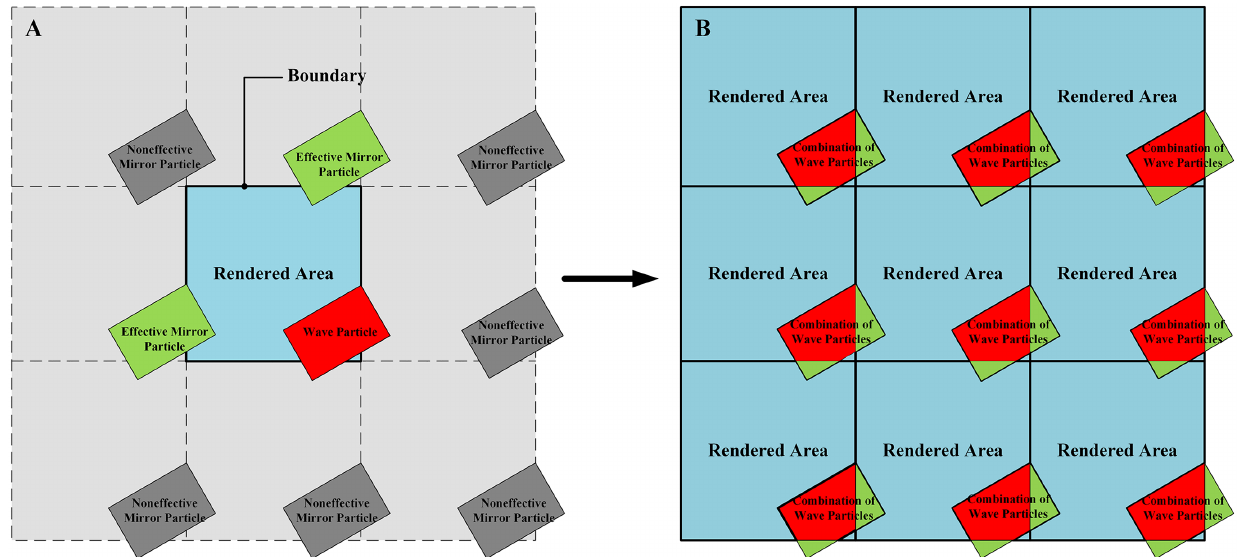
Fig 8. Solution to aperiodicity of wind-driven ocean waves. (A) The relevant location of a reference wave particle and its mirrors. (B) The combination of wave particles located in boundary areas of ocean patches ( Rendered Area ).